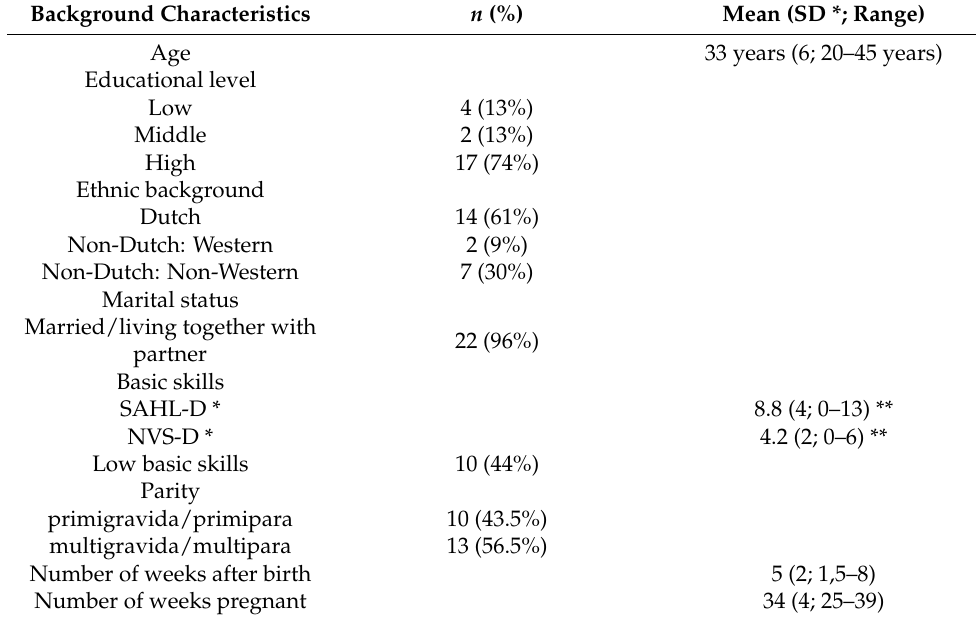
Table 1. Background characteristics of interview participants ( n =